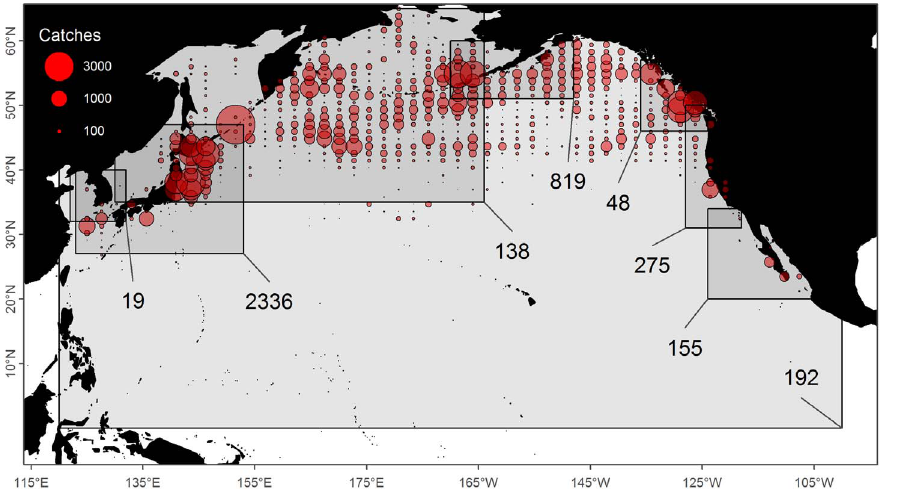
Figure 3. Map of reported blue, fin, sei and common minke whale catch locations (1905 – 1971). These catch locations were used to infer potential locations for blue whale catches without known locations. 41% of catches are known only to broad, management-defined regions (shaded boxes) which are shown with their corresponding blue whale catches.